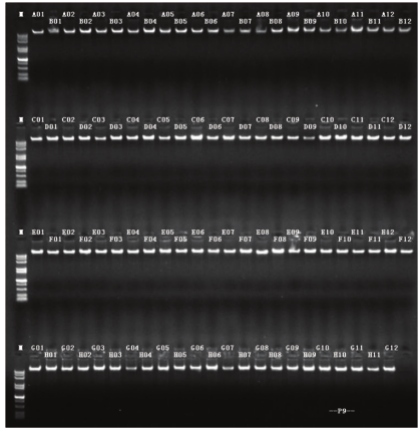
Figure 1: PCR-amplified DNA analyzed on a 3% agarose gel and visualized by ethidium bromide staining.